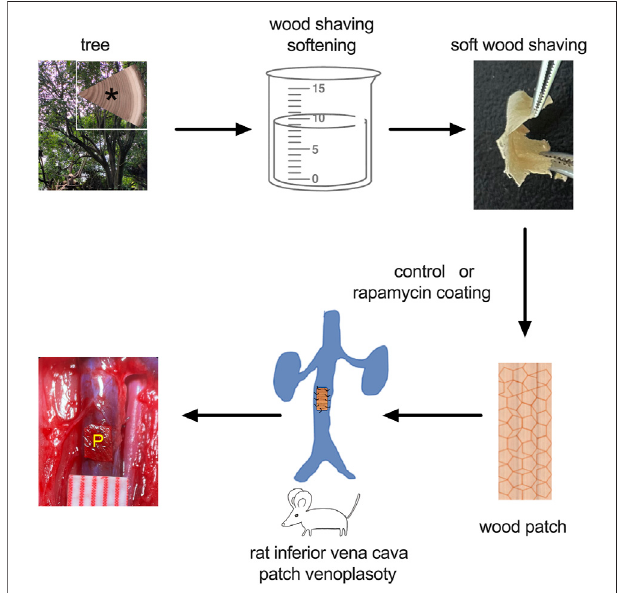
FIGURE 1 | Illustration of the study design. * shows the area from which the wood was